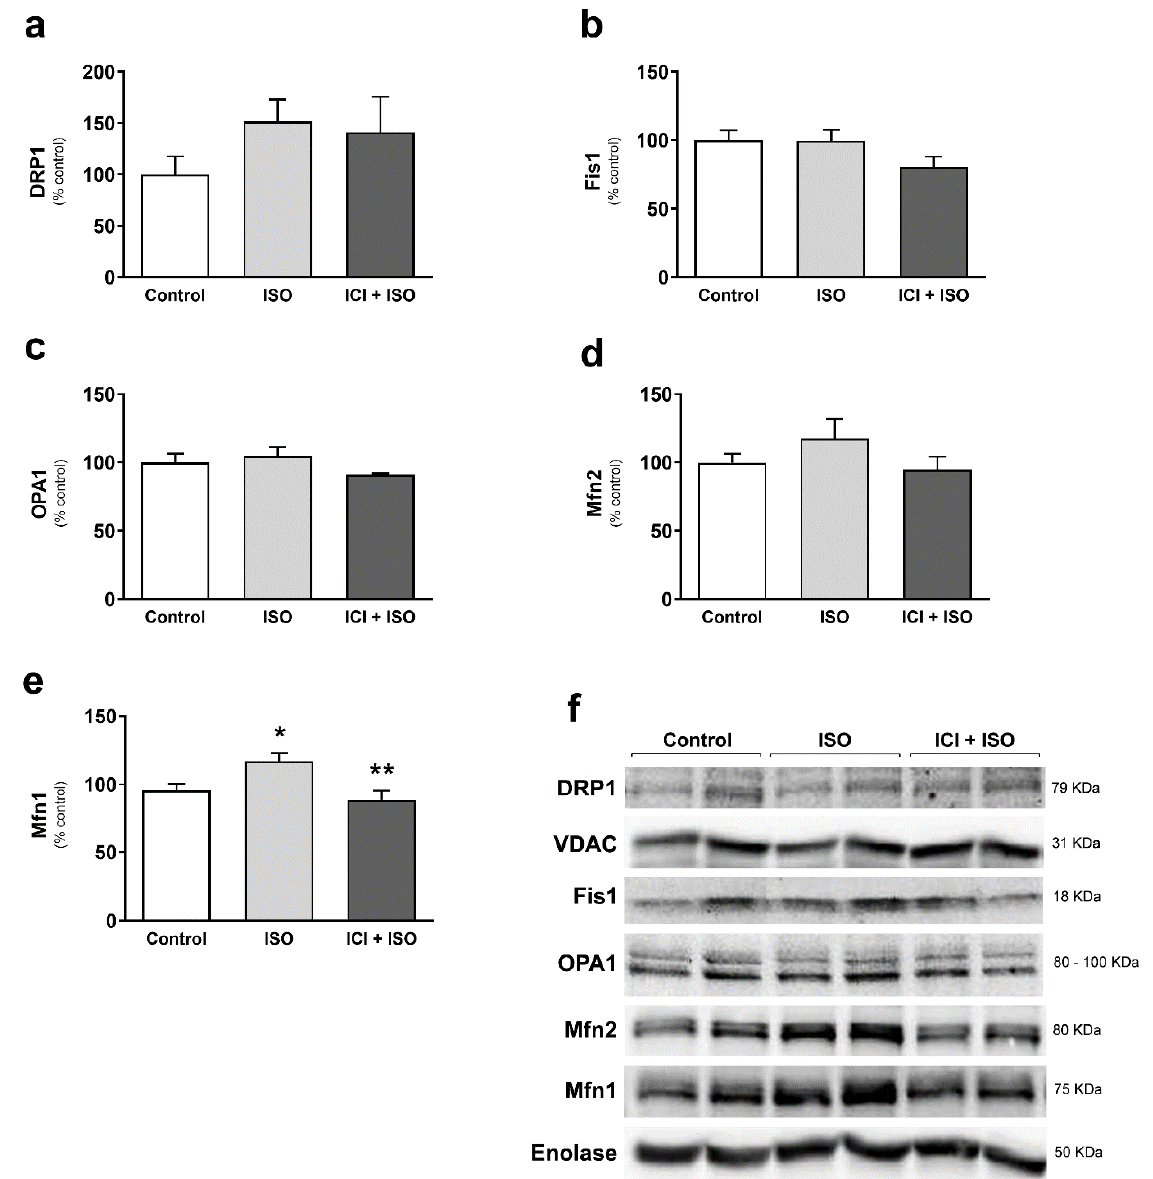
Figure 6. Pharmacological activation of β 2 -ARs increases Mfn1 expression in skeletal muscle. DRP1 (mitochondrial fraction) ( a ), Fis1 ( b ), OPA1 ( c ), Mfn2 ( d ), and Mfn1 ( e ) protein expression, and immunoblot representative images ( f ) in tibialis anterior muscles from mice treated with the non-selective β -AR agonist isoproterenol (ISO—single dose—10 mg/kg, i.p. 30 min), with or without β 2 -AR receptor blockade with ICI 118,551 (single dose—10 mg/kg, i.p., 30 min prior to ISO treatment). Enolase and VDAC were used as loading control for total lysate and mitochondrial fraction protein expression, respectively. Data are presented as mean ± SE. * p < 0.05 vs. control and ** p < 0.05 vs. ISO. n = 5/group.